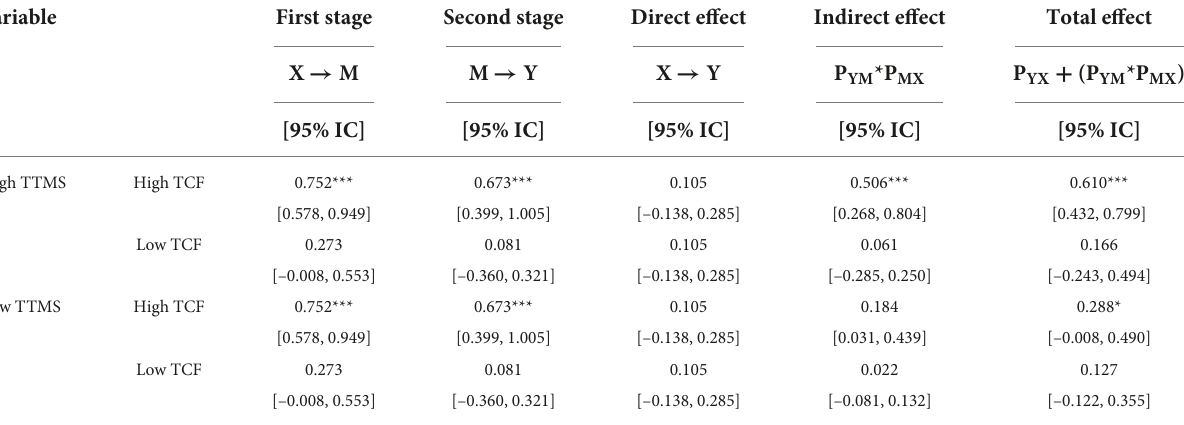
TABLE 5 Two-stage moderated mediation effect analysis.